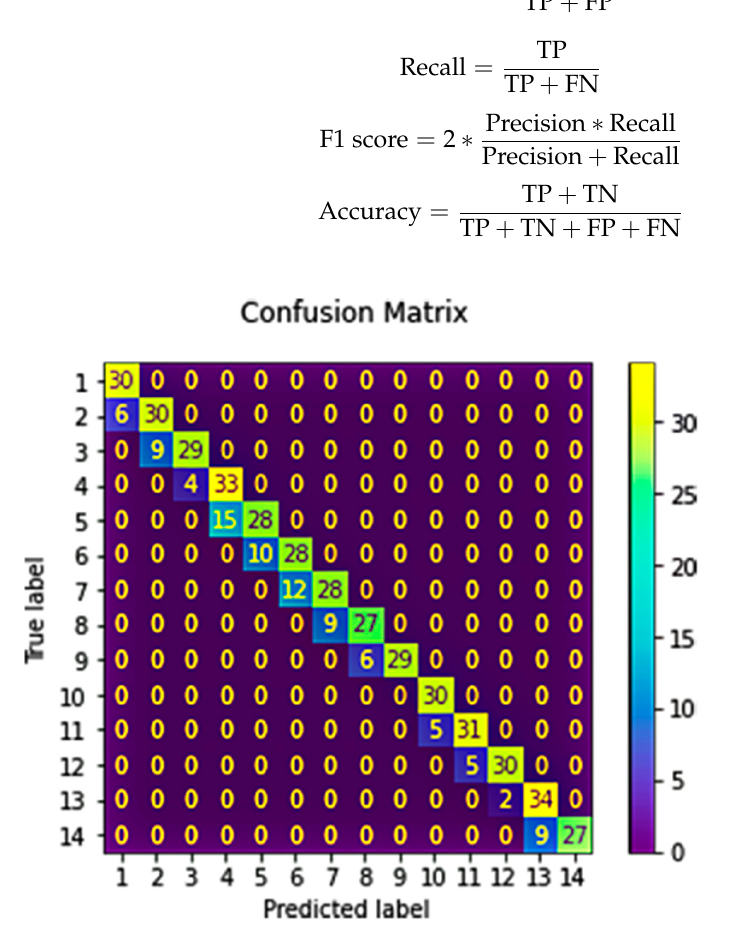
Figure 3. Confusion matrix and classification report.